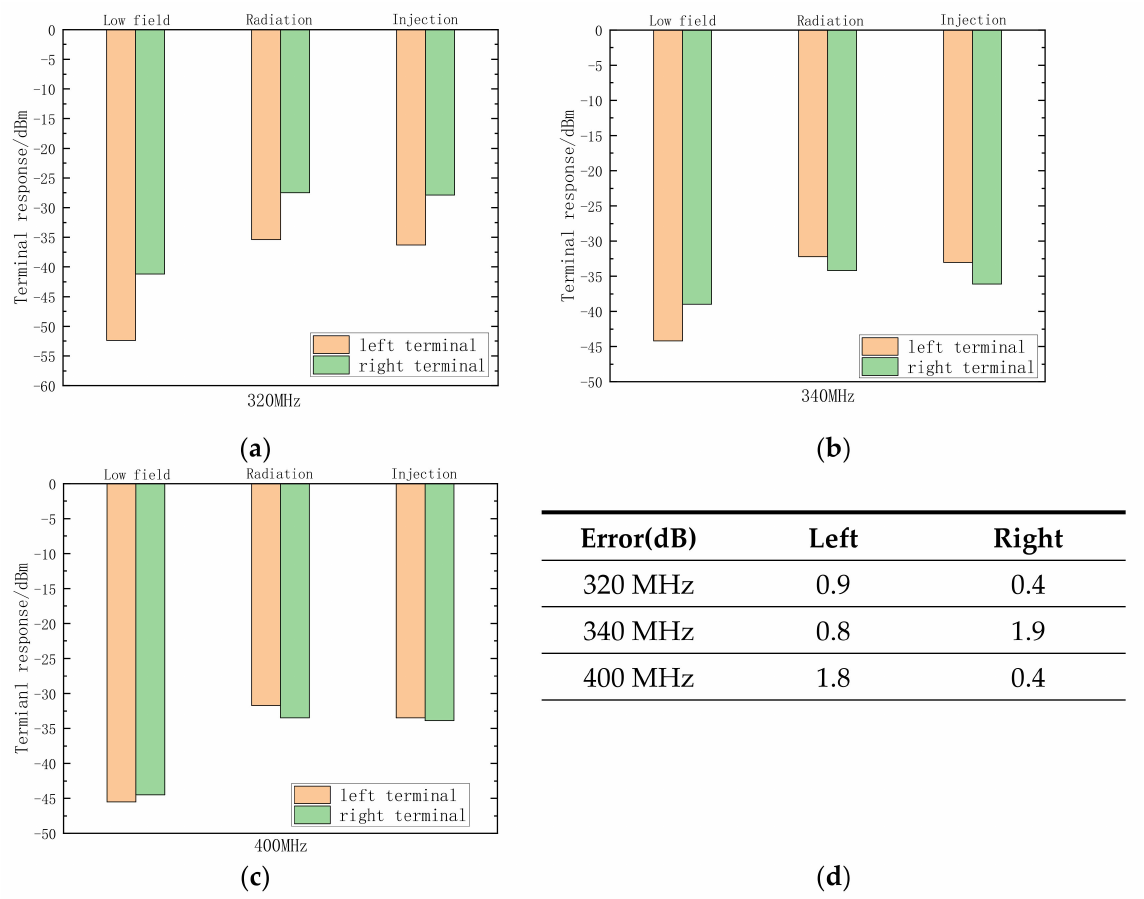
Figure 10. Test results: ( a ) 320 MHz; ( b ) 340 MHz; ( c ) 400 MHz; ( d )